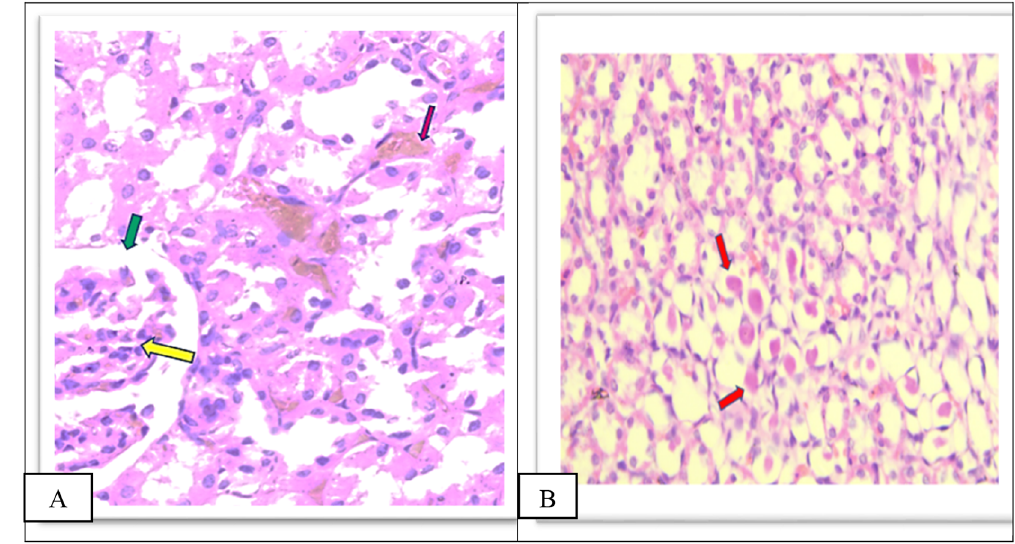
Figure 8. A. Section of the kidney tissue of rat (Group IV) show moderate congestion of interstitial (Pink arrow), moderate congestion of glomeruli (yellow arrow) and moderate increased of urinary space (Green arrow)(H&E, (cid:1) 40).B.Thesectionofratkidneytissue(GroupIV)showsdegenerationand moderateamountof hyaline cast formation (Red arrow) (H&E, (cid:1) 40).